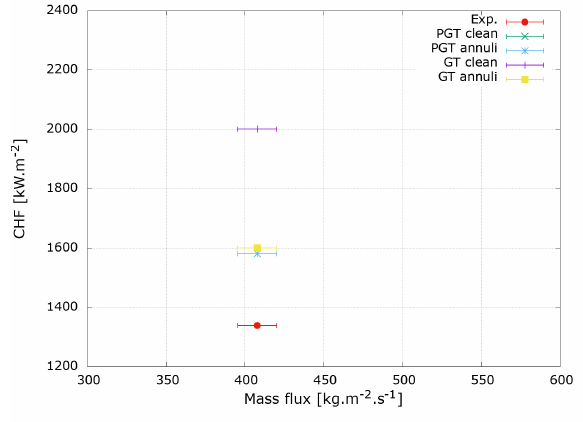
Figure 8. Comparison of CHF results against calcu- lations with PGT correlation and Groeneveld’s tables at p in = 220 kPa and T in = 62 ℃.